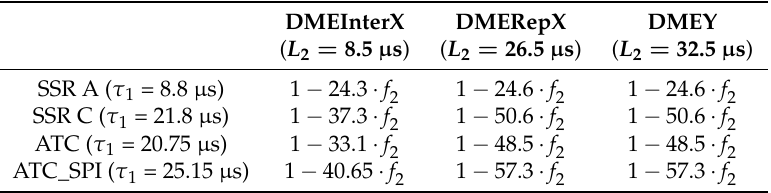
Table 1. Calculation for the mean recognition